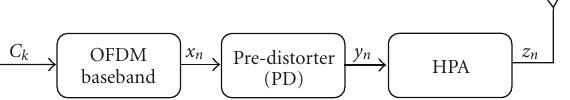
Figure 1: The discrete communication system model for the downlink.